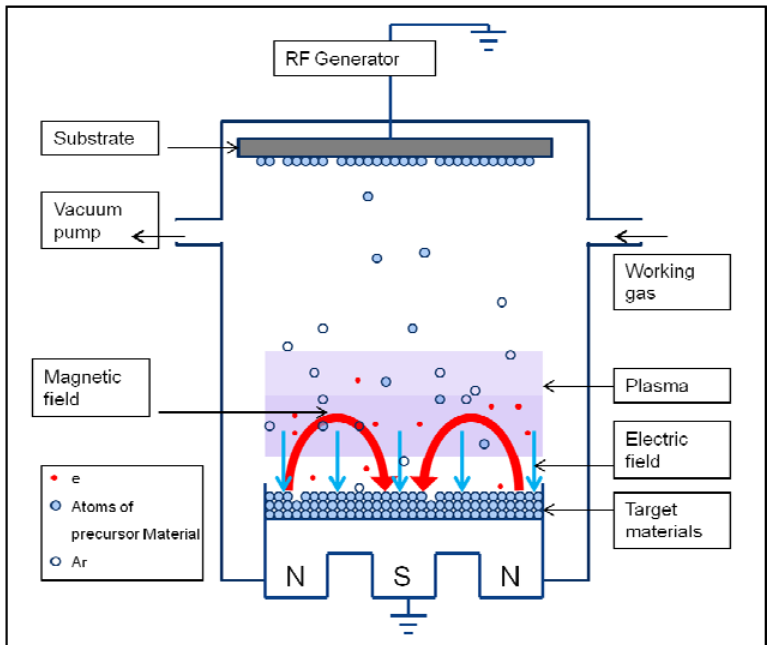
Figure 2. Schematic representation of RF magnetron